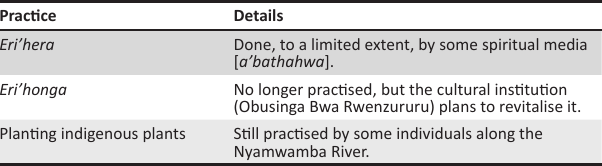
TABLE 1: Status of traditional ecological responses. Practice Details